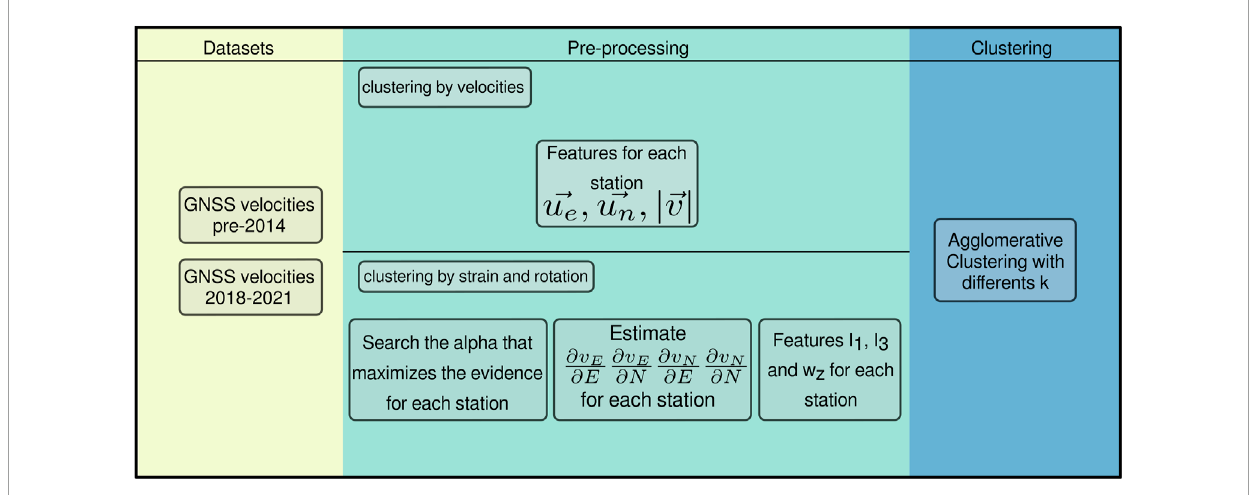
FIGURE 3 Flowchart summarizing the different stages of the clustering analysis. In a first step, the two datasets of velocities are generated from the GNSS data, then these two datasets are pre-processed using the two the methods presented in this work (i.e., clustering by velocity and strain-rotation). In a final step, the features extracted from these datasets are clustered using the Agglomerative